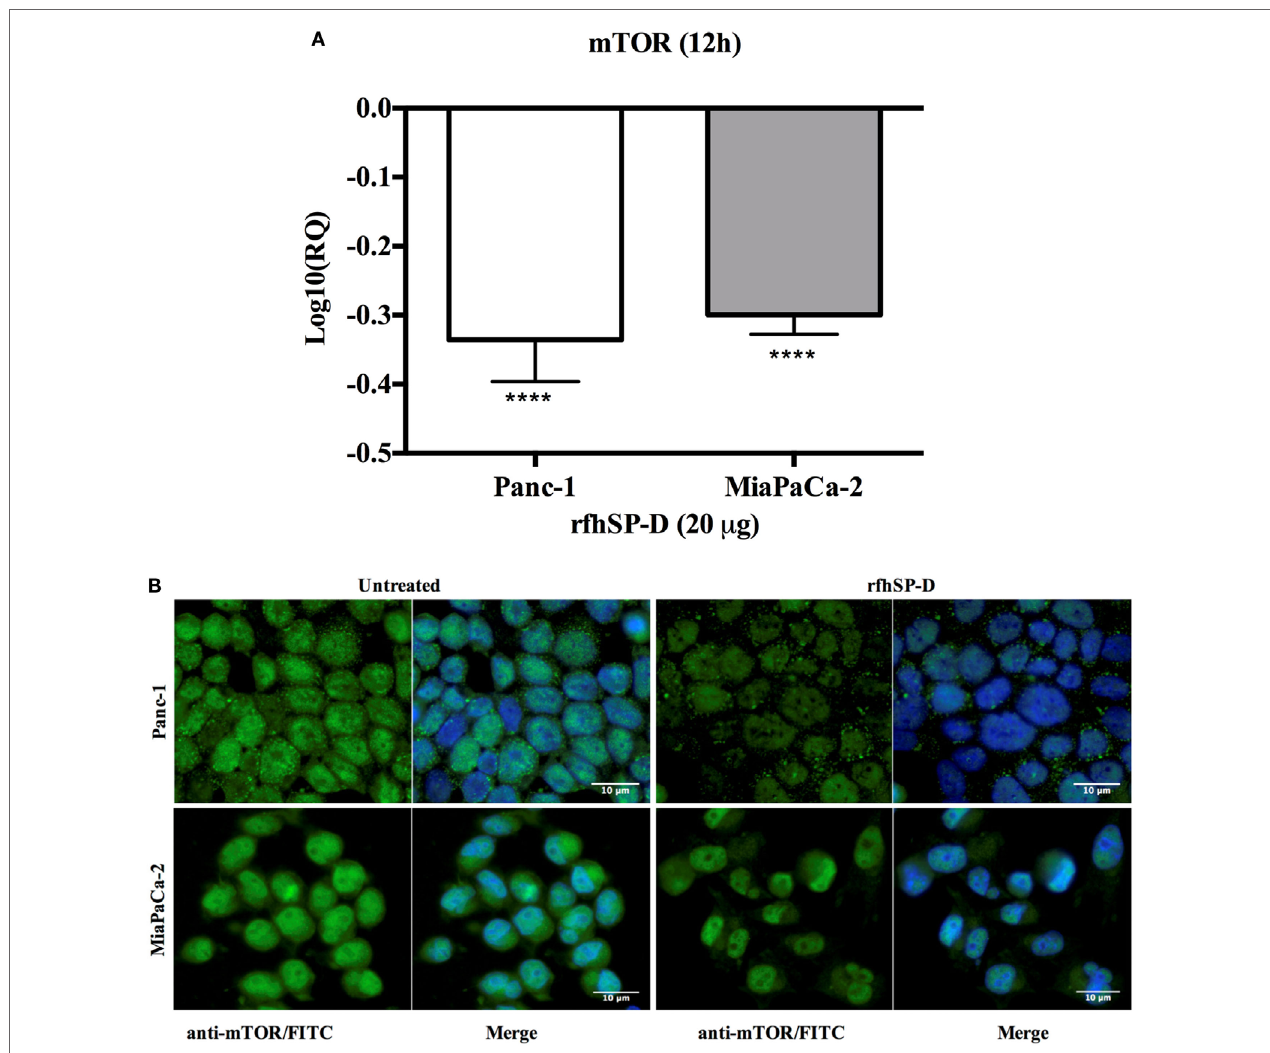
FigUre 8 | rfhSP-D downregulated the survival pathway, mTOR. (a) rfhSP-D treatment of Panc-1 and MiaPaCa-2 cells downregulated the mRNA expression of mTOR (**** p < 0.0001). (b) Immunofluorescence microscopy showed reduced cytoplasmic levels of mTOR following treatment as compared to the untreated. Nuclear accumulation is clearly visible in the rfhSP-D treated